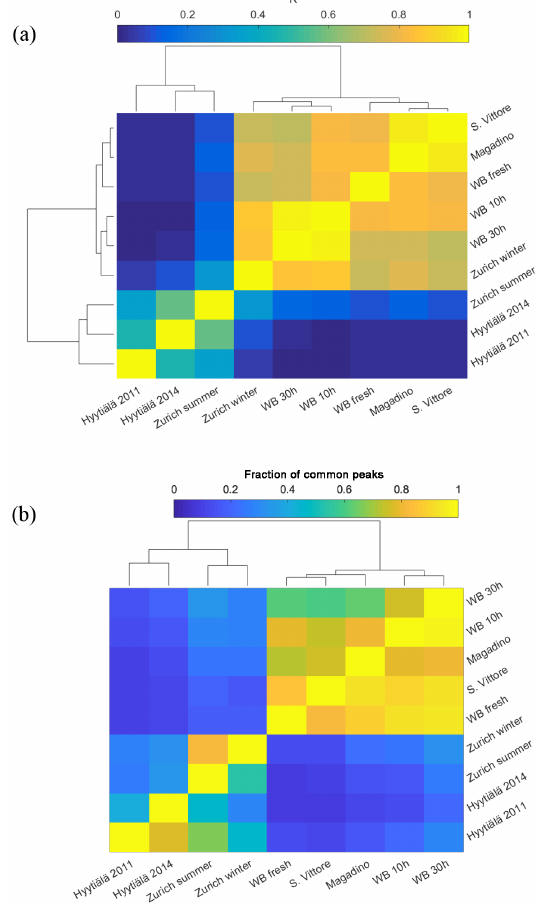
Figure 3. (a) Correlation matrix of mass spectra sorted by hierarchi- cal cluster analysis that also depicts the similarity as dendrograms. (b) Fraction of common peaks of a sample with the sample indi- cated on the y axis normalized to the total number of peaks of the respective sample sorted by hierarchical cluster analysis that also depicts the similarity as dendrograms.